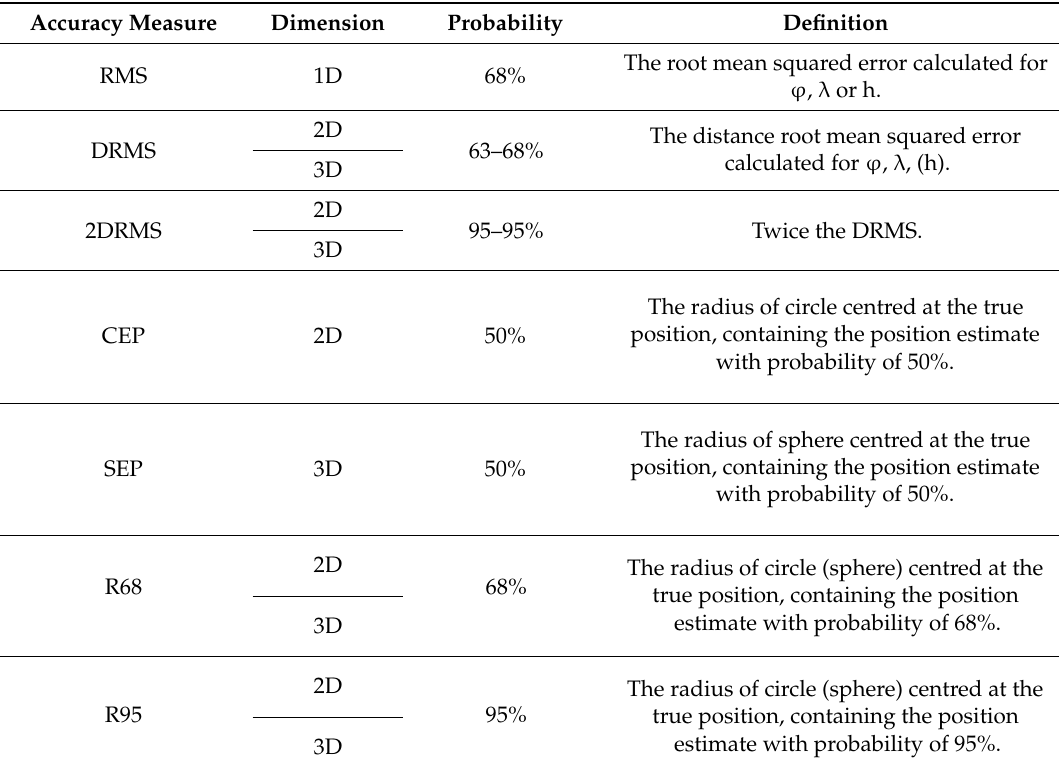
Table 5. Selected position accuracy measures. Own study based on: